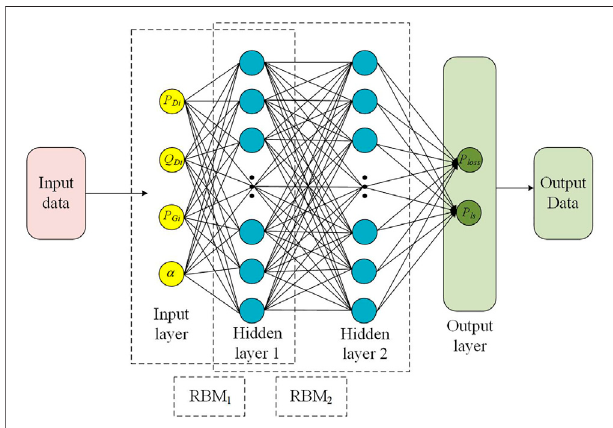
FIGURE 4 | Deep belief network structure